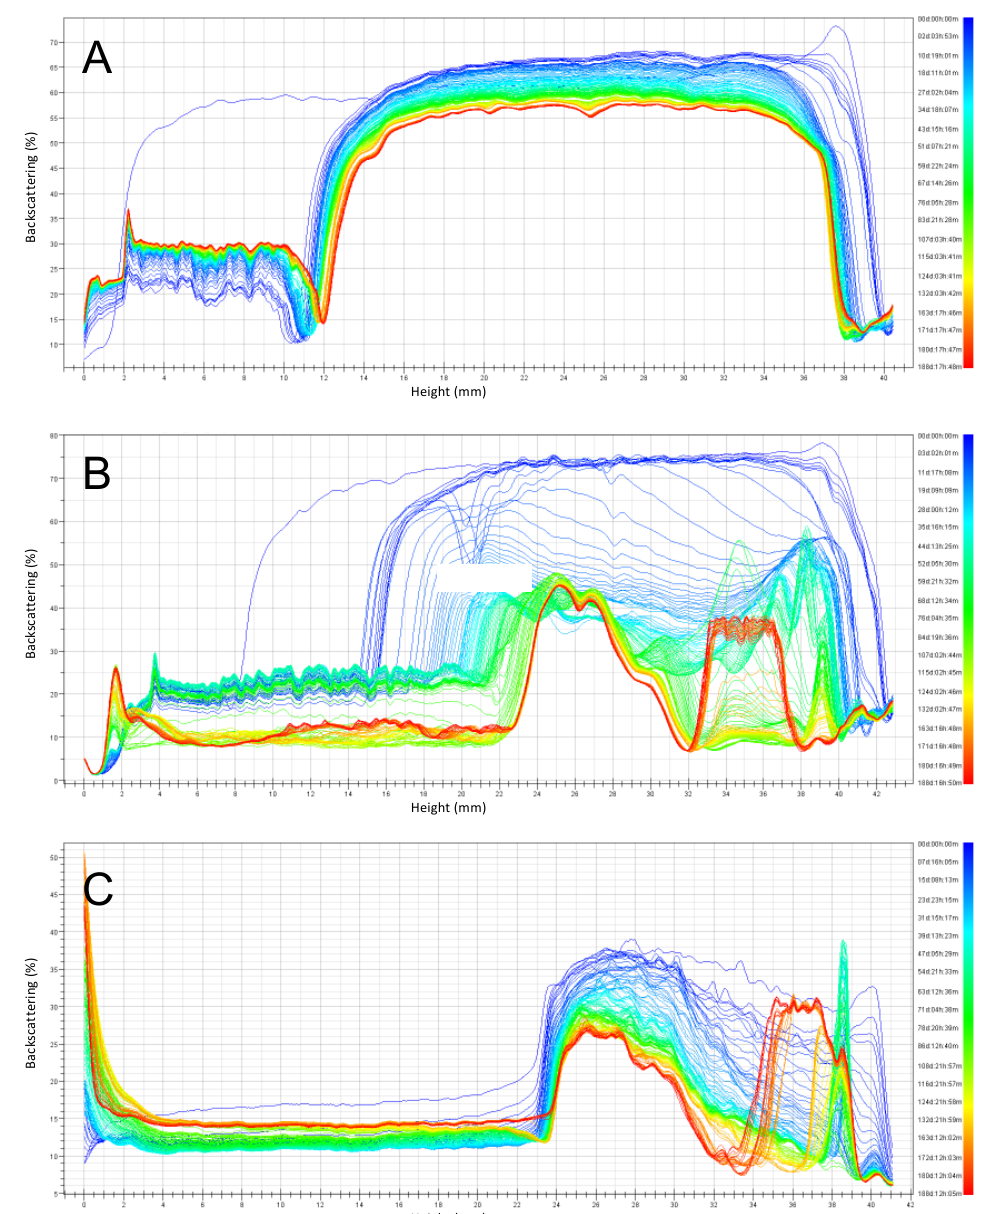
Figure 6. Backscattering profiles of emulsions prepared at pH 6 and stored for six months at 30 °C. ( A ) Emulsions stabilized by rapeseed protein precipitated at pH 3 (RPP3), ( B ) Emulsions stabilized by rapeseed protein precipitated at pH 6.5 (RPP6.5), ( C ) Emulsions stabilized by soy lecithin.